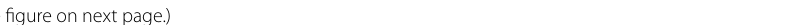
figure on next Fig. 2 A 20-days-old female patient weighted 2750 gm presented clinically by respiratory distress-Sarnat stage II. Conventional MRI Axial T1WI ( A , B ) shows rim of high signal intensities (germinal matrix hemorrhage) in the left occipital horn and adjacent to the frontal horn of lateral ventricle (red arrows). Axial T2WI ( C ) shows dilatation of the ventricular system (black arrow) and dilatation of subarachnoid spaces (central and peripheral atrophic changes) (blue arrows), indistinct grey white matter differentiation (green arrows). Multivoxel MRS ( D ) and MRS Spectrum ( E ) long TE 144 show decreased NAA peak, and increased CHO peak also Multivoxel MRS ( F ) and spectrum ( G ) short TE 35 show marked increased lac peak. Lac/Cr at basal ganglia & thalamus ratio 2.7 denoting marked stage of HIE (grade III). Outcome: Cerebral